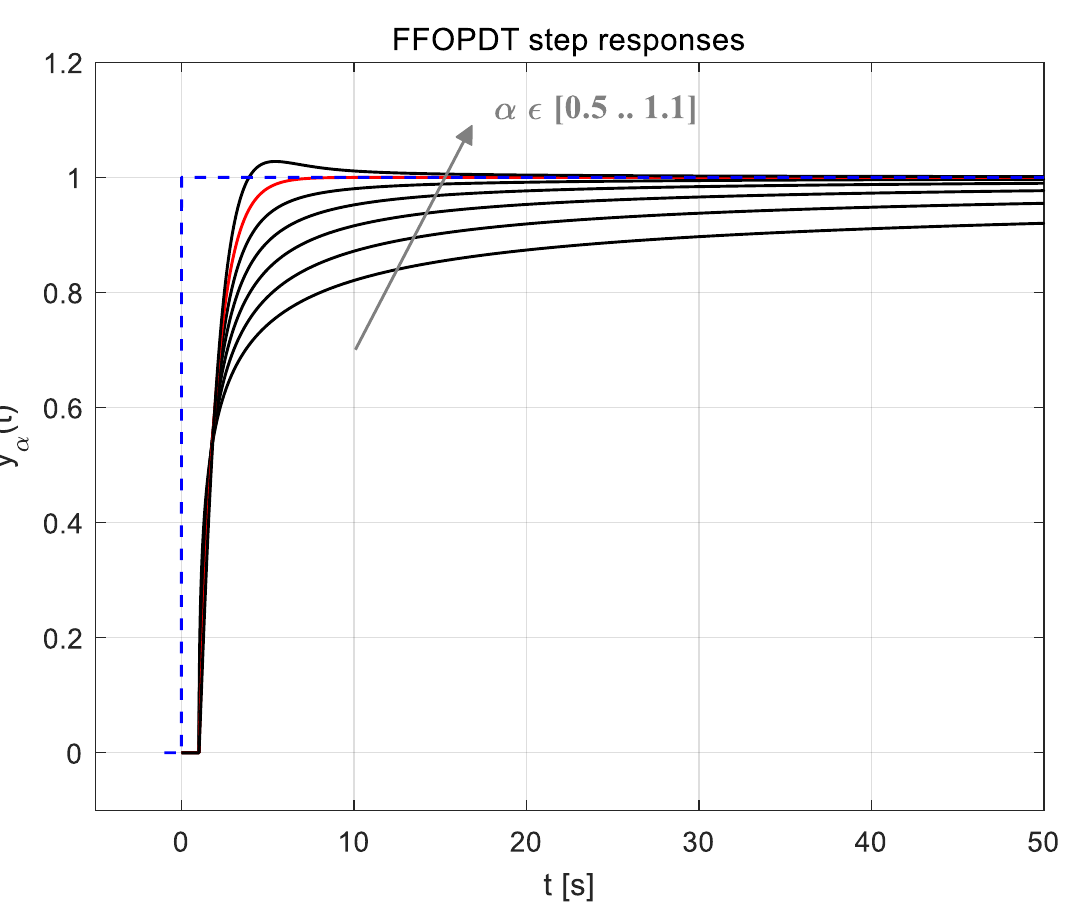
Figure 1. Step responses of FFOPDT models with α ∈ [0.5, 1.1]. The step response of an FOPDT model ( α = 1) is depicted in red line.